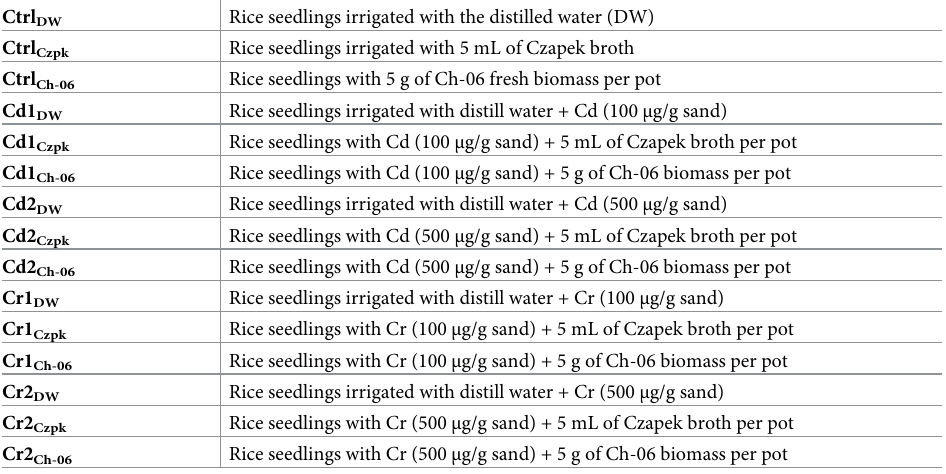
Table 1. Initial screening of rice seedlings treated with or without Ch-06 CF under Cd and Cr